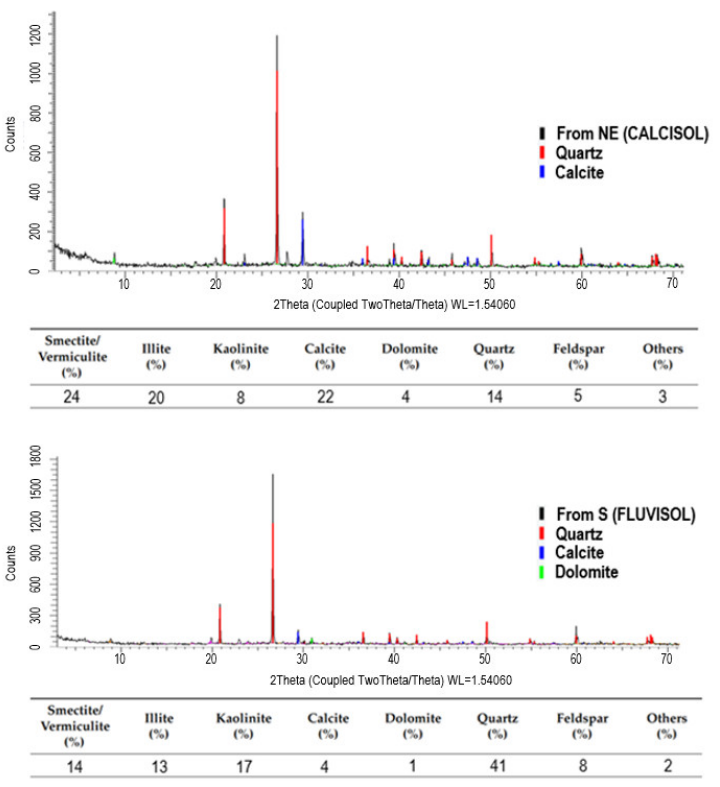
Figure 7. X-ray diffractograms of sediments caught from Calcisols and Fluvisols.